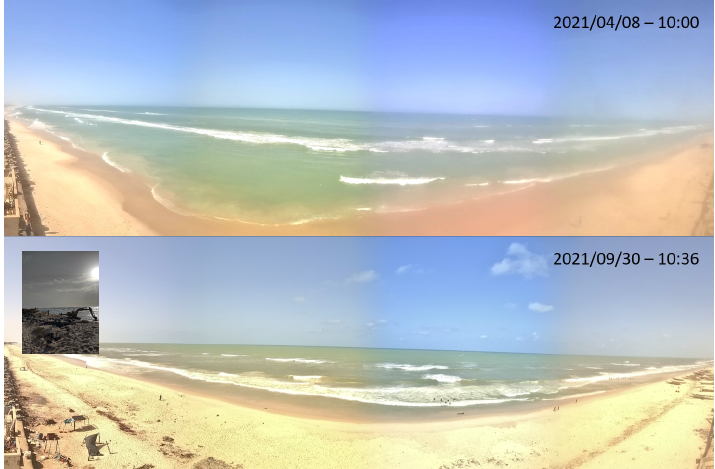
Figure 2. Images acquired with the camera (see Figure 1 for location) on the indicated time. A small picture (bottom panel, on the left) shows the on-going construction of the riprap.